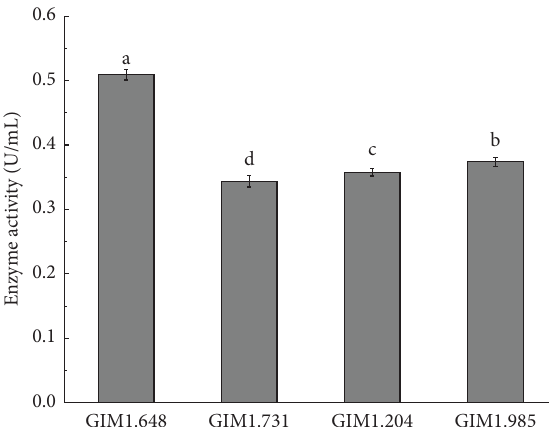
Figure 2: Four kinds of Lactobacillus β -glucosidase activity. Diferent letters indicate signifcant data diferences ( P < 0 . 05).